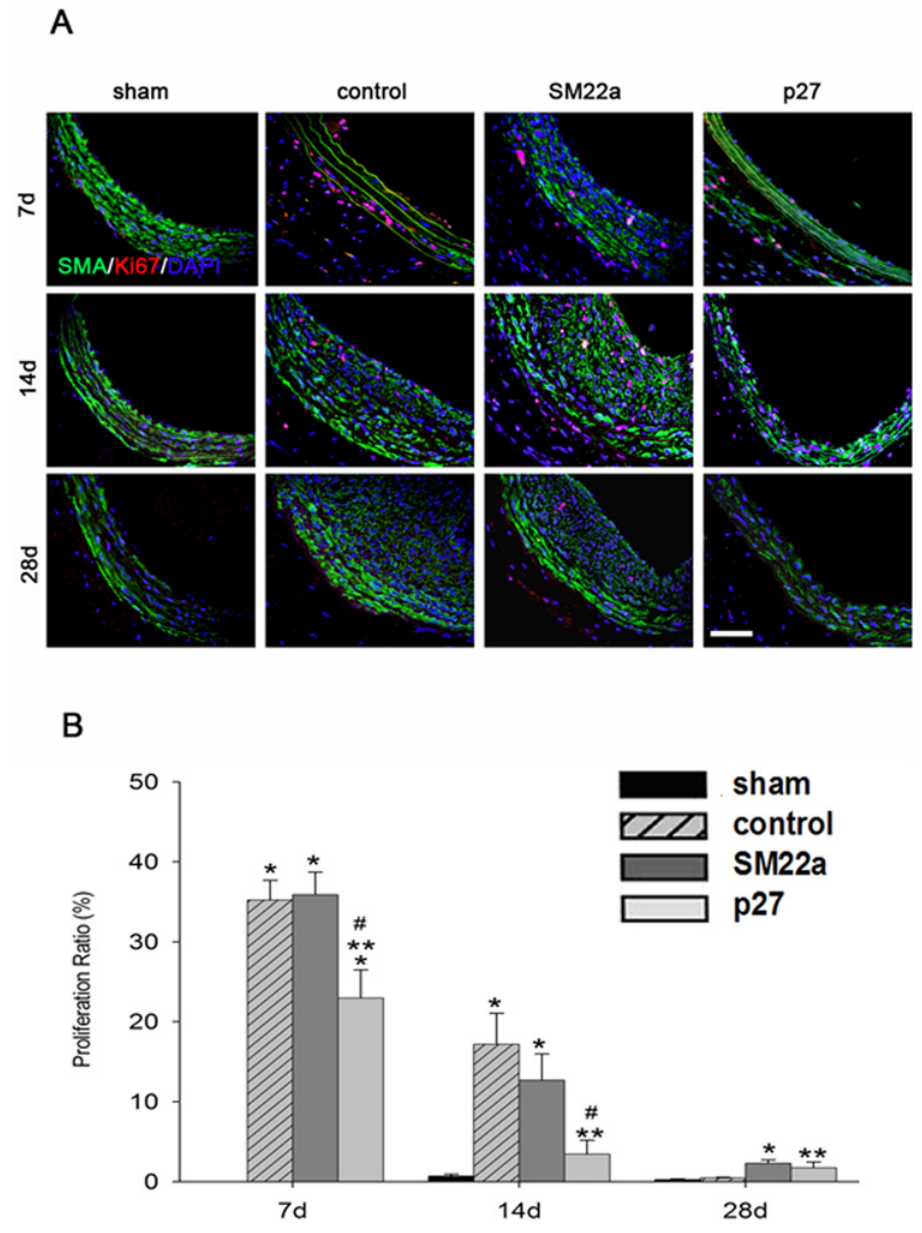
Fig 5. Inhibition of neointimal hyperplasia with Lenti-SM22alpha-P27 lentivirus vector in Rat Carotid Artery Balloon Injury models. A. Ki67 immunofluorescence staining in sham, control, SM22a and p27 carotid artery groups at 7, 14, and 28 days after the balloon injury. Ki67 is shown in red, SMA is shown in green while DAPI is shown in blue. Scale bar: 300 μ m. B. Measurement of proliferation ratio in different groups using Ki67 staining. * (p < 0.05, 7 days control, SM22a, p27 vs. sham. 14 days control, SM22a vs. sham, 28 days SM22a vs. sham). ** (p < 0.05, p27 vs. control in 7 days, 14 days and 28 days). #(p < 0.05, p27 vs. SM22a in 7 days, 14 days and 28 days). Error bars represent the mean ± S.E. (n = 3).